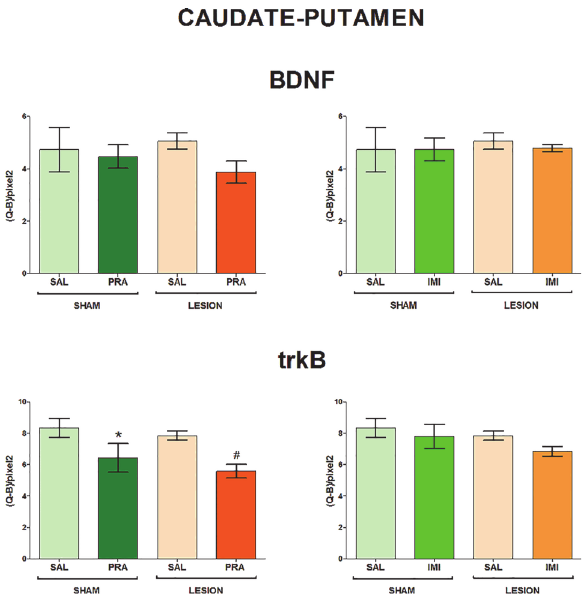
Fig 7. The influence of 6-OHDA, pramipexole and imipramine on BDNF and trkB mRNAs in the caudate-putamen. n = 9 – 10. For further explanations see Figs. 1 and 2.